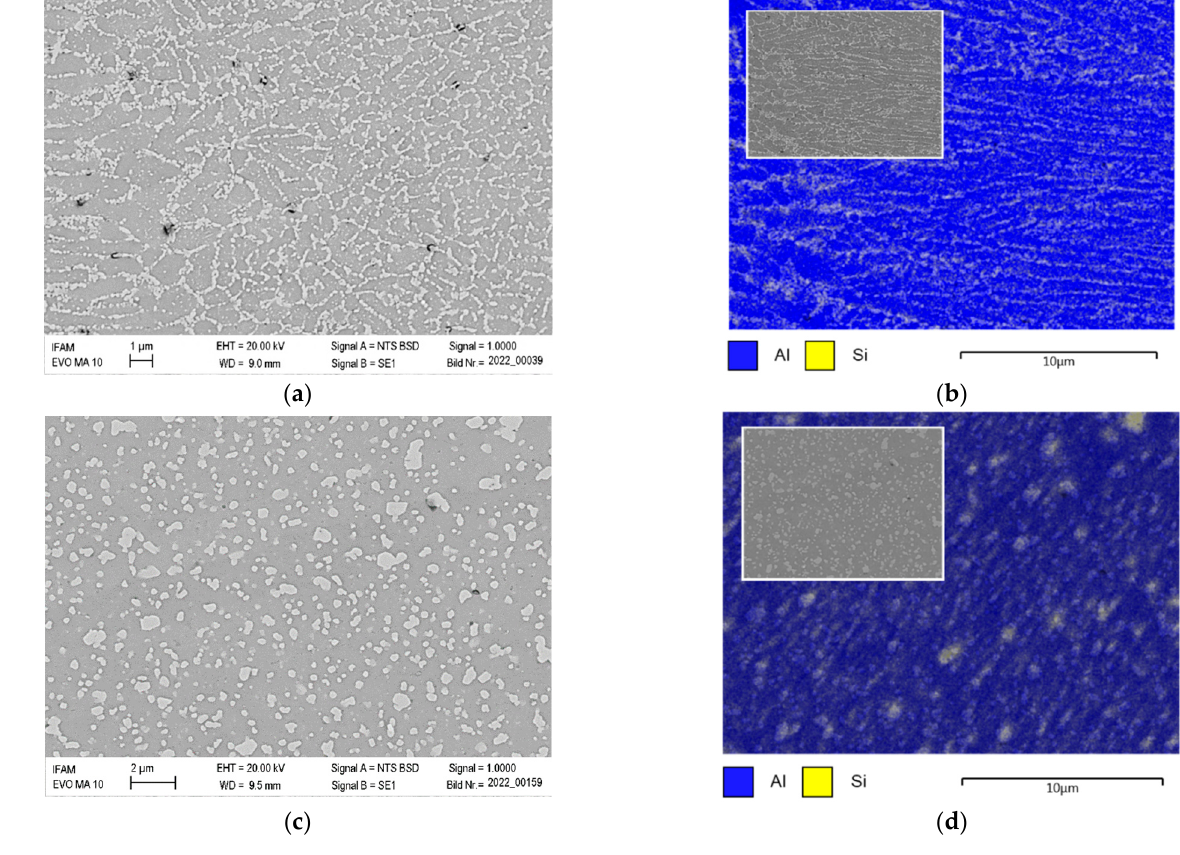
Figure 14. Microstructure of: ( a , b ) microstructure ( a ) and EDX area scan ( b ) for a sample produced at a 0° polar angle and tested at room temperature, and ( c , d ) microstructure ( c ) and EDX area scan ( d ) for a sample produced at a 0° polar angle and tested at 450 °C. Image is contrast-enhanced by 30% using the MS Word image formatting feature to increase material contrast in ( a , c ). Identification of bright-grey phases with silicon is confirmed. Images ( c , d ) confirm dissolution of the cellular structure as well as growth of the silicon phase.